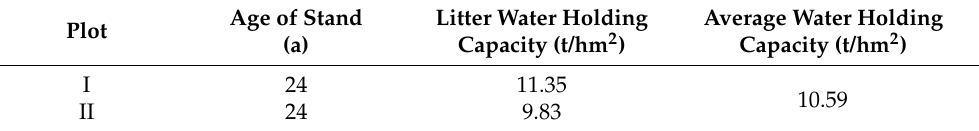
Table 5. Litter water holding capacity .